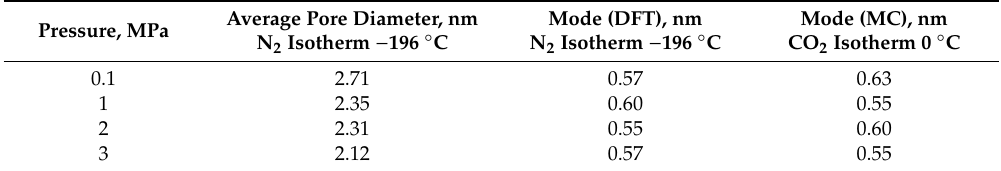
Table 2. Average pore diameter and mode diameters determined on the basis of nitrogen isotherm using the density functional theory (DFT) method and carbon dioxide isotherm using the Monte Carlo (MC) method for olive pomace-derived carbon materials produced at 800 ◦ C, under carbon dioxide atmosphere and pressure of 0.1–3 MPa.